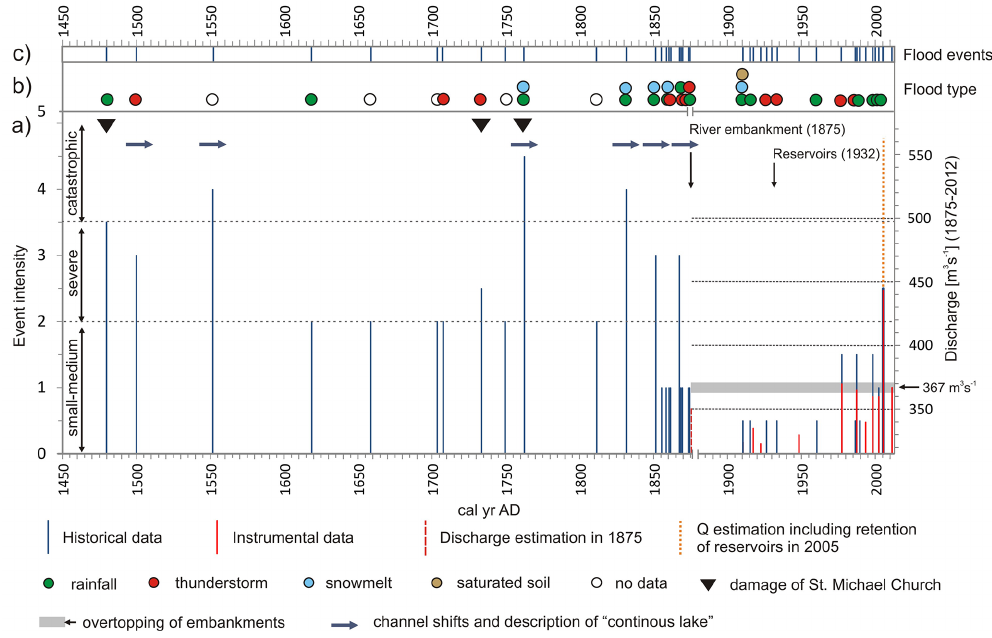
Figure 7. Flood chronology of the Aare River in the Hasli Valley from AD 1480 to 2012. (a) Flood intensities reconstructed from docu- mentary and geomorphological evidence (blue columns) and instrumental data (red columns). Event intensities M (left scale; referring to Table 1 and Eq. 1) are estimated for the period AD 1480–2012, whereas maximum annual discharges >300m 3 s − 1 (right scale) recorded at the Brienzwiler gauging station are valid for the period AD 1908–2012. Discharge measurements in AD 1875 were conducted on-site by engineers of the Aare correction project. Measured discharges and event intensity level are influenced by structural mitigations such as river embankments since AD 1875 and retention capacities of reservoirs since AD 1932 as in the case of the 2005 flood (arrows). Triangles represent damage to the Sankt Michael church by flooding and severe aggradation caused by the Alpbach River. (b) Hydro-climatological cause of floods (legend below) according to historical written sources, WSL flood data bank, expert reports, newspapers and precipitation data. (c) Composite flood frequencies. Data as in (a)